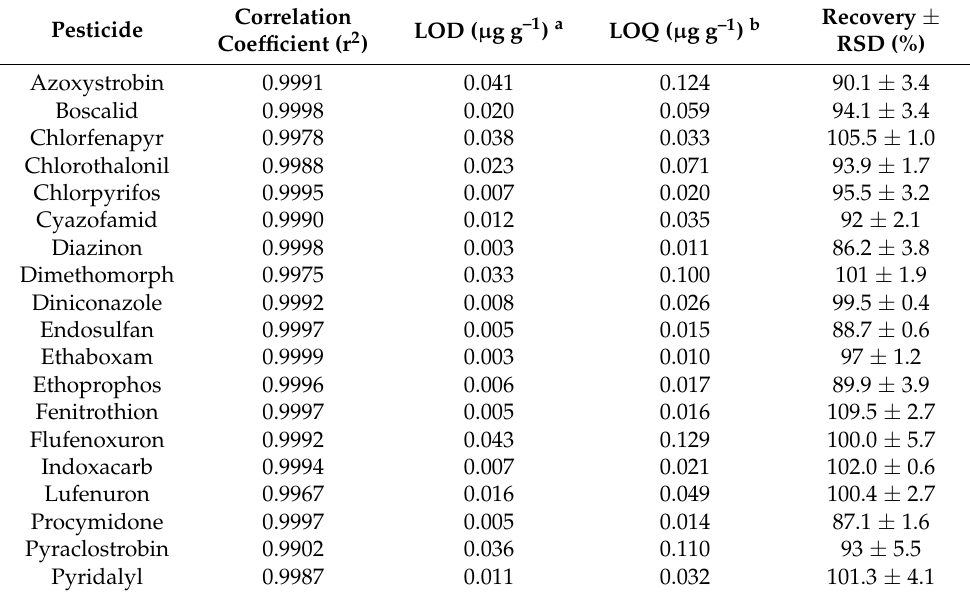
Table 3. Validation parameters (linearity, LOD, LOQ, and recoveries) in main pesticides detected in our